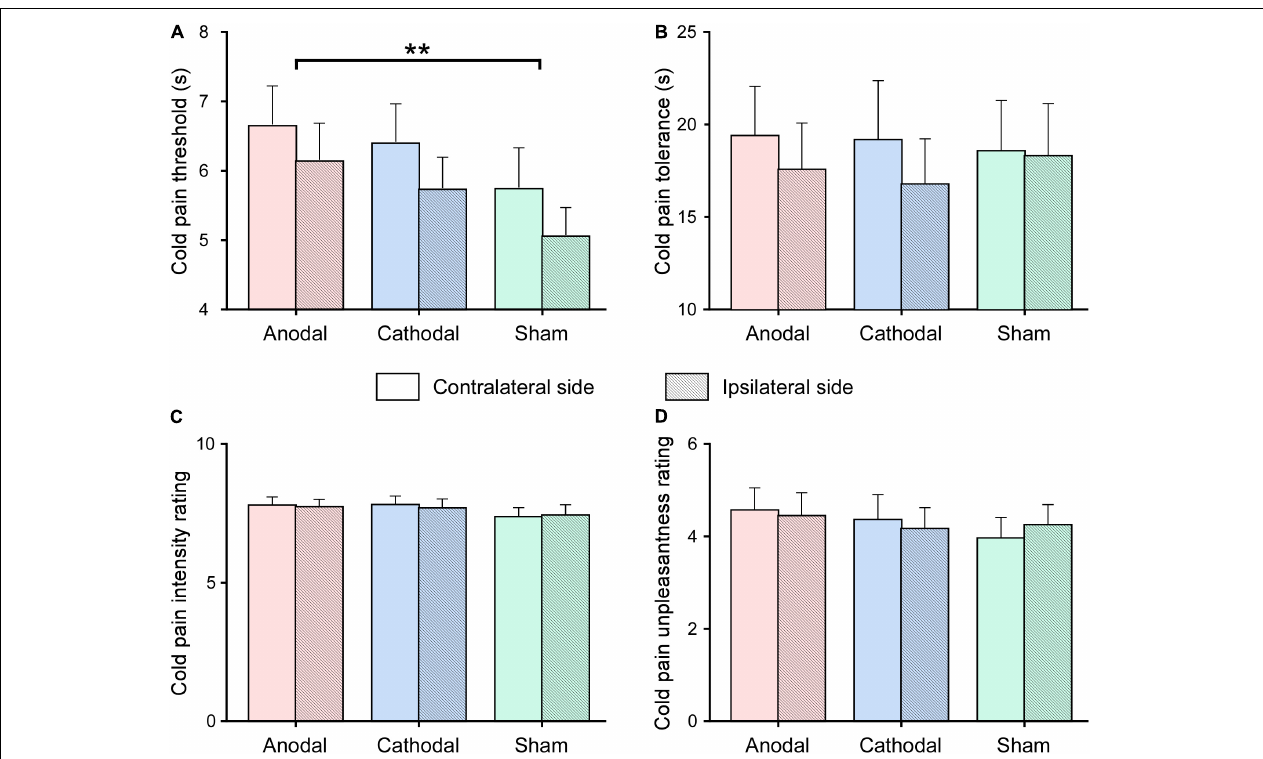
FIGURE 3 | Effects of high-definition transcranial direct current (HD-tDCS) on cold pain sensitivity. Cold pain threshold (measured in seconds; A ) and tolerance (measured in seconds; B ), as well as cold pain intensity (measured on the 0–10 scale; C ) and unpleasantness (measured on the 0–10 scale; D ) ratings were measured after the application of anodal, cathodal, sham HD-tDCS, for hands contralateral and ipsilateral to the HD-tDCS side. Data are expressed as mean ± SEM. Compared with sham stimulation, the cold pain threshold was significantly increased after anodal HD-tDCS, regardless of whether the cold pain stimulus was delivered to the hand contralateral or ipsilateral to the HD-tDCS side. ** p < 0.01, paired-sample t